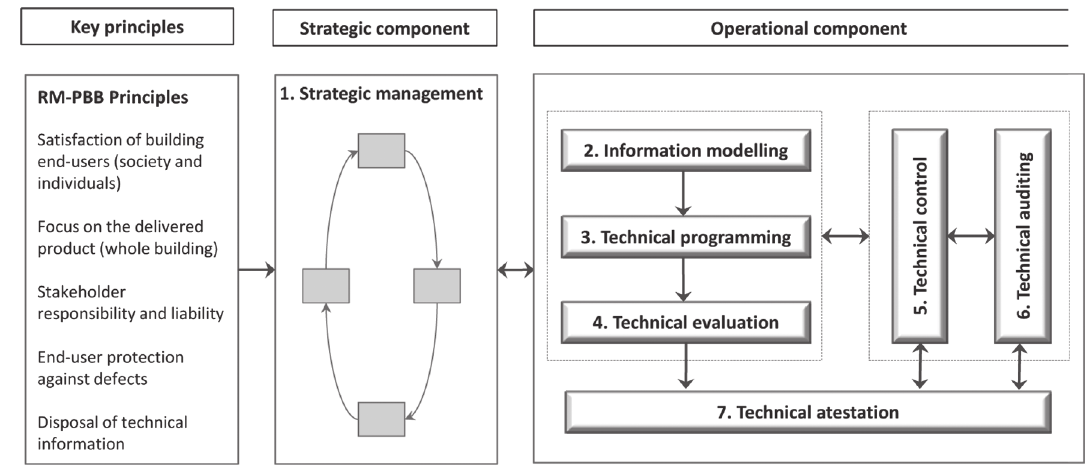
Fig. 1. Risk-Managed Performance-Based Building (RM-PBB) framework (Almeida et al .